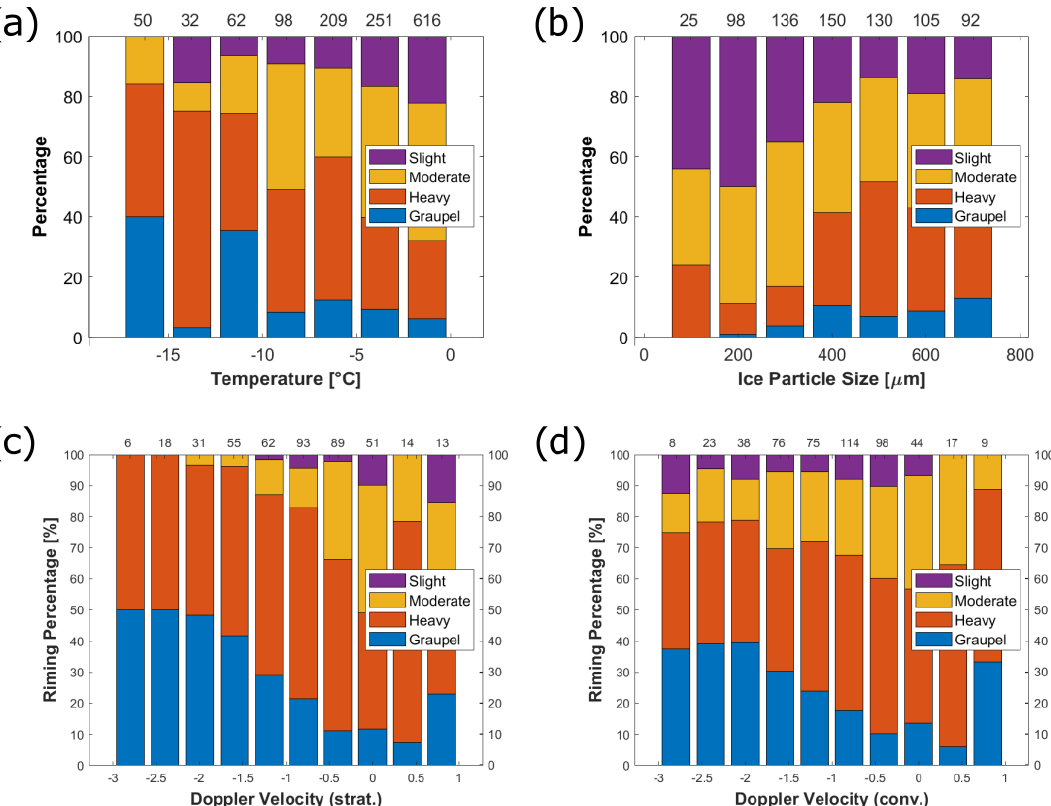
Figure 7. The relative occurrence of particles of different riming degree as defined in Fig. 2: slight (purple), moderate (yellow) and heavy riming (red) as well as graupel (blue) in relation to ambient temperature (a) , ice particle size (b) , and HCR Doppler velocity (c, d) similar to Fig. 4. The values on the upper x axis correspond to the total number of particles per bin.